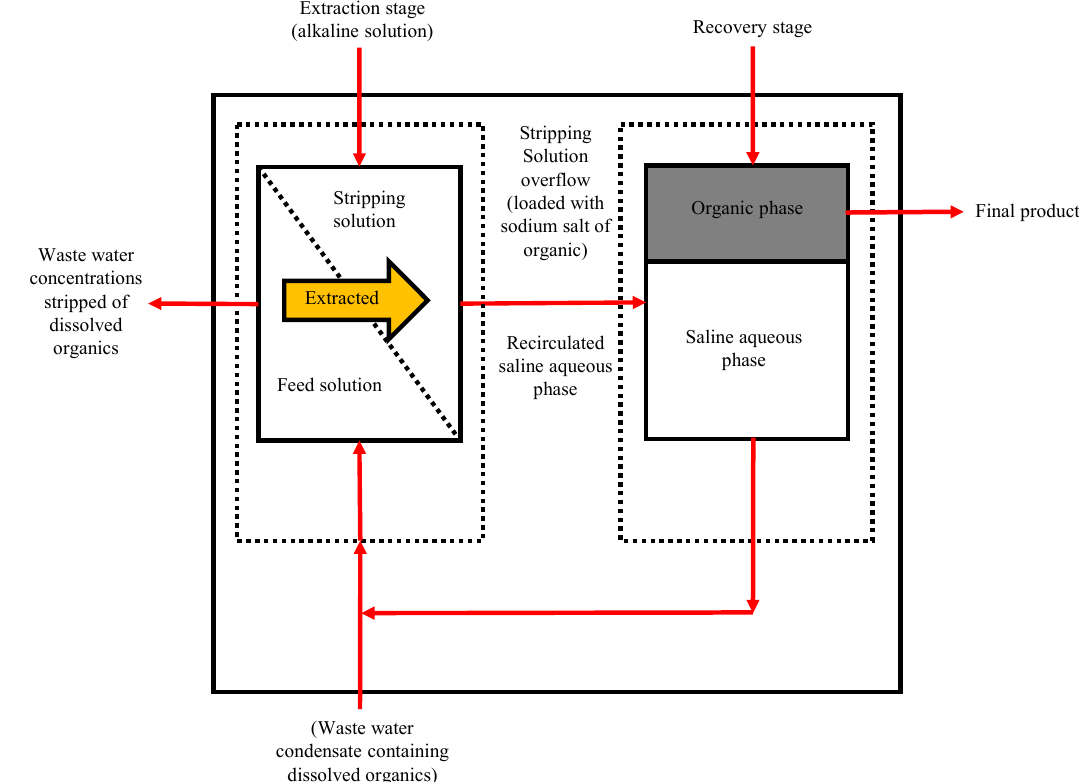
Figure 7. Operating principle of membrane aromatic recovery system (MARS) for recovery of phenolic compounds.